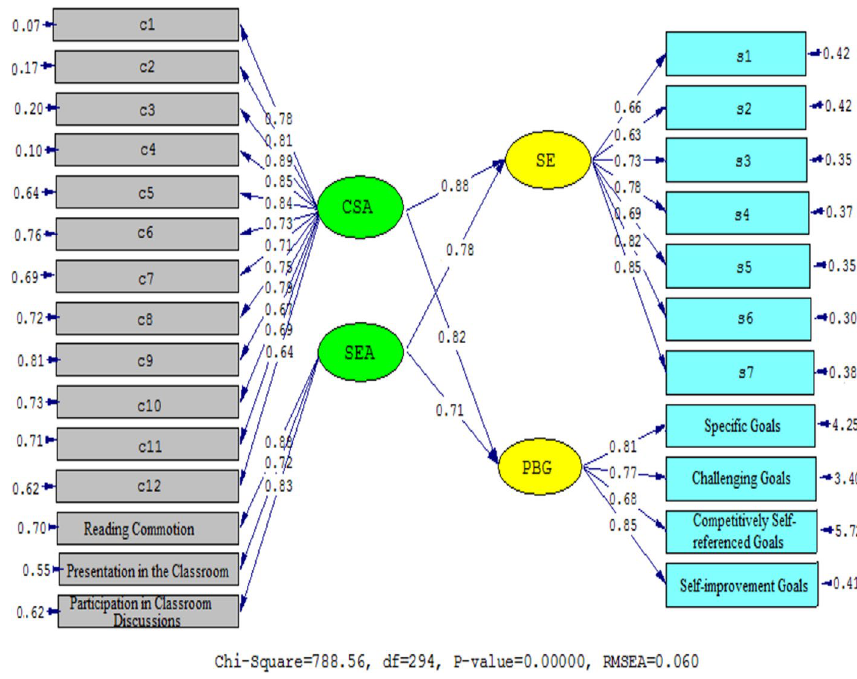
Fig. 2 Schematic representation of path coefficient values for the relationships between CSA, SEA, PBG, and SE (model 1)